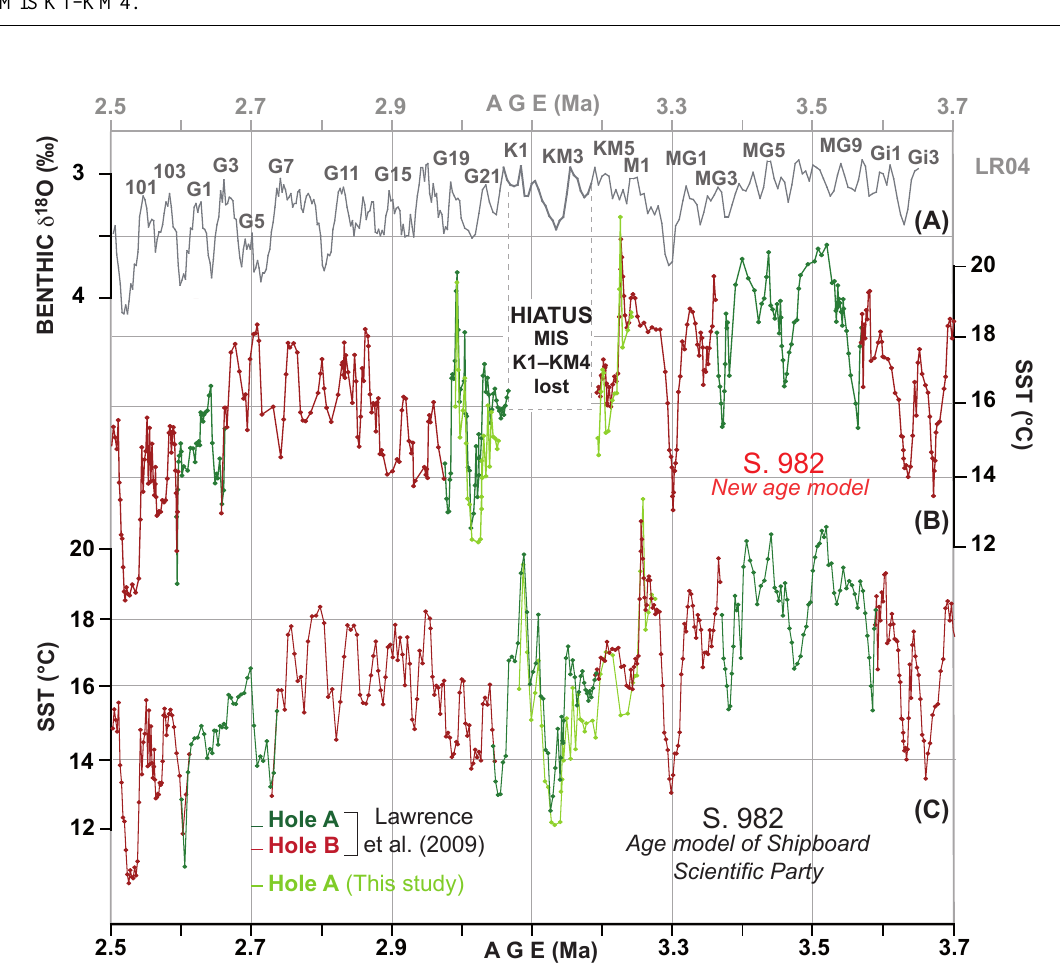
0 data of Hole A (light green) 37